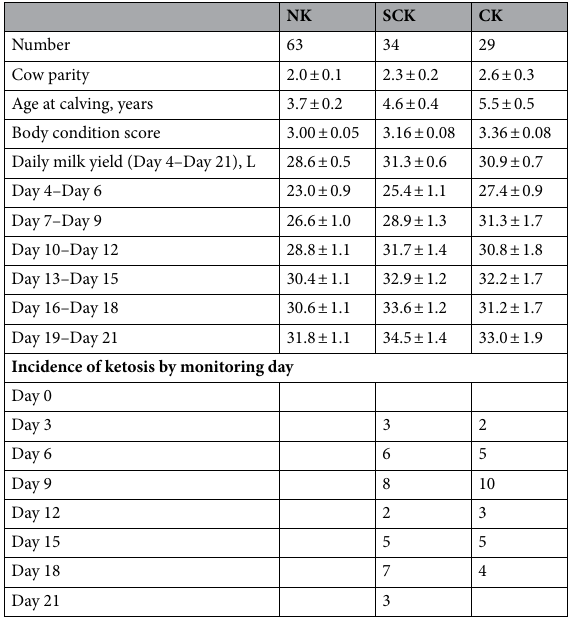
Table 1. Descriptive statistics for the Holstein Friesian cows included in the study. Data are expressed as mean ± standard error of the means. NK, non-ketosis group; SCK, subclinical ketosis group; CK, clinical ketosis group. mean ± standard of error of the